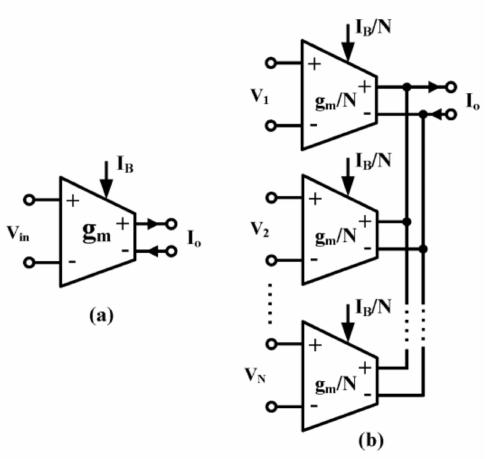
Figure A1. Single-input fully-di ff erential OTA ( a ) and multiple-input fully-di ff erential OTA ( b